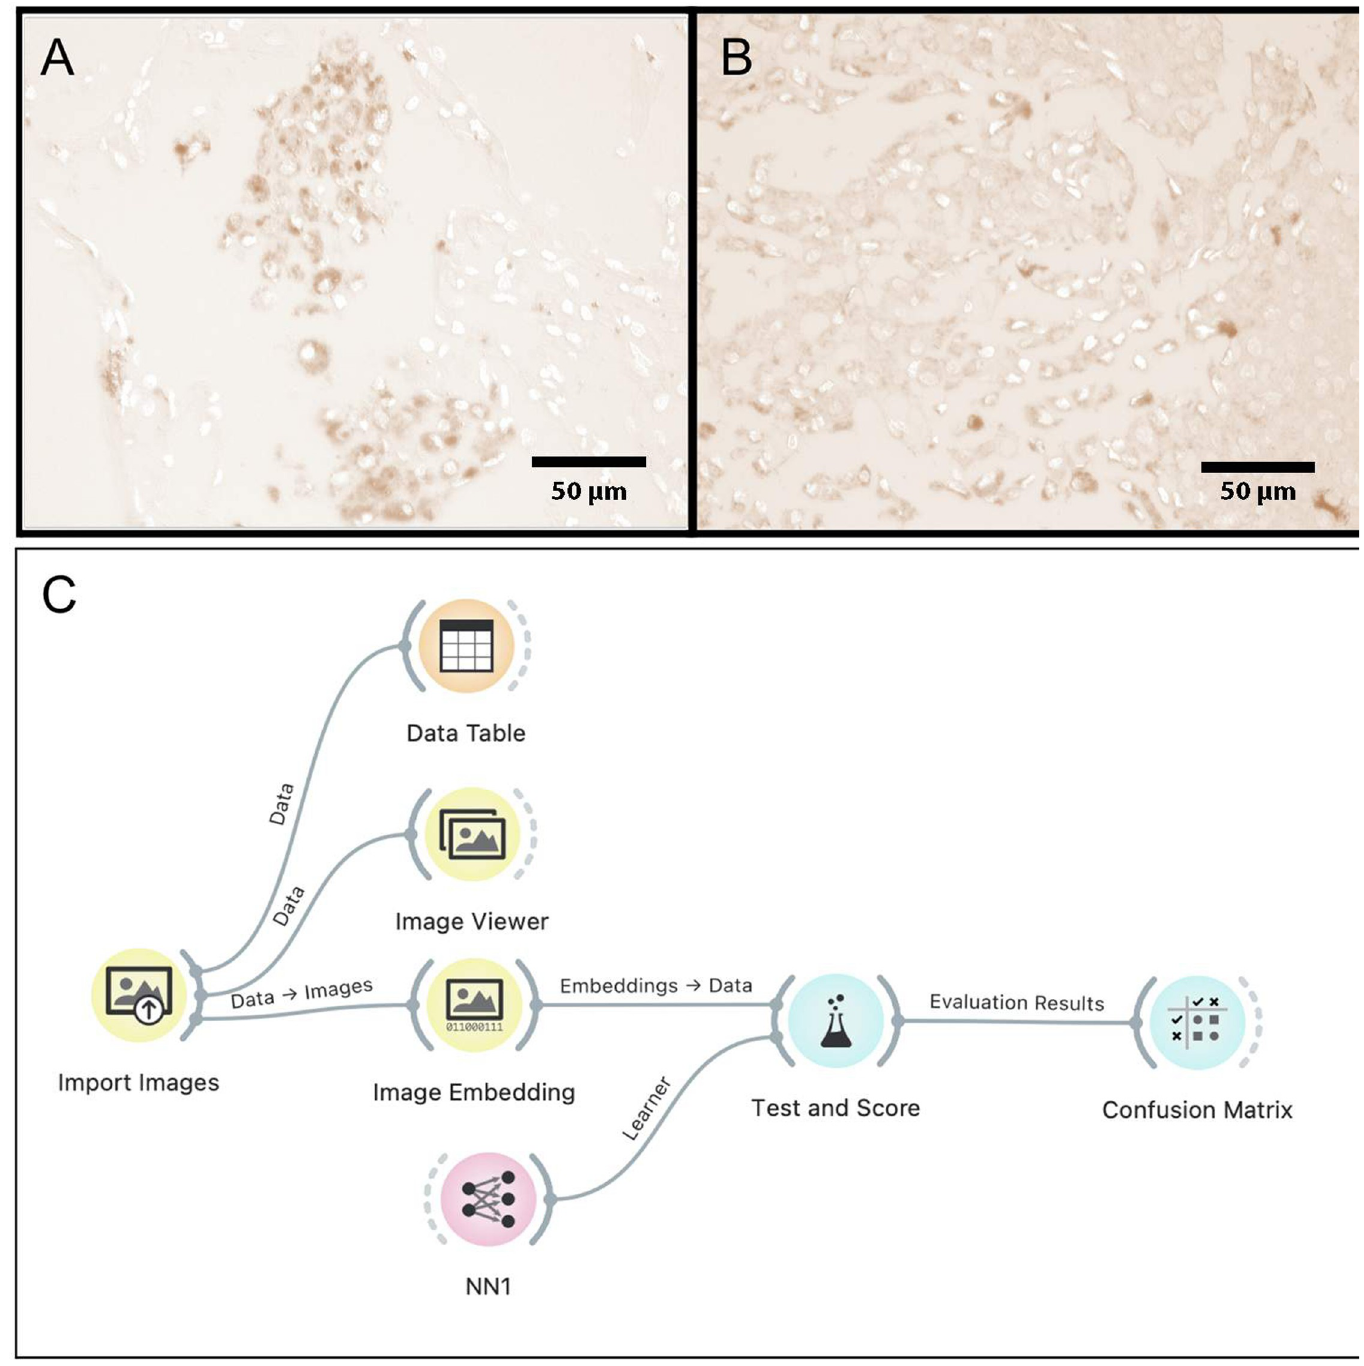
Fig 2. Example of BGN expression in DAB only in photomicrographs, after color deconvolution in normal breast tissue (A) and with cancer (B), bars represent 50 μ m. Flowchart of the supervised neural network analysis using Orange 3 software (C). NN1:supervised neural network analysis. https://doi.org/10.1371/journal.pone.0282176.g002 leading to the misinterpretation of results [14]. Finally, the amount of BGN in tissue sections does not necessarily reflect its biological effect as it mainly indicates BGN that has been seques- tered in the extracellular matrix, for example, as part of the fibrotic scar [30]. Despite these